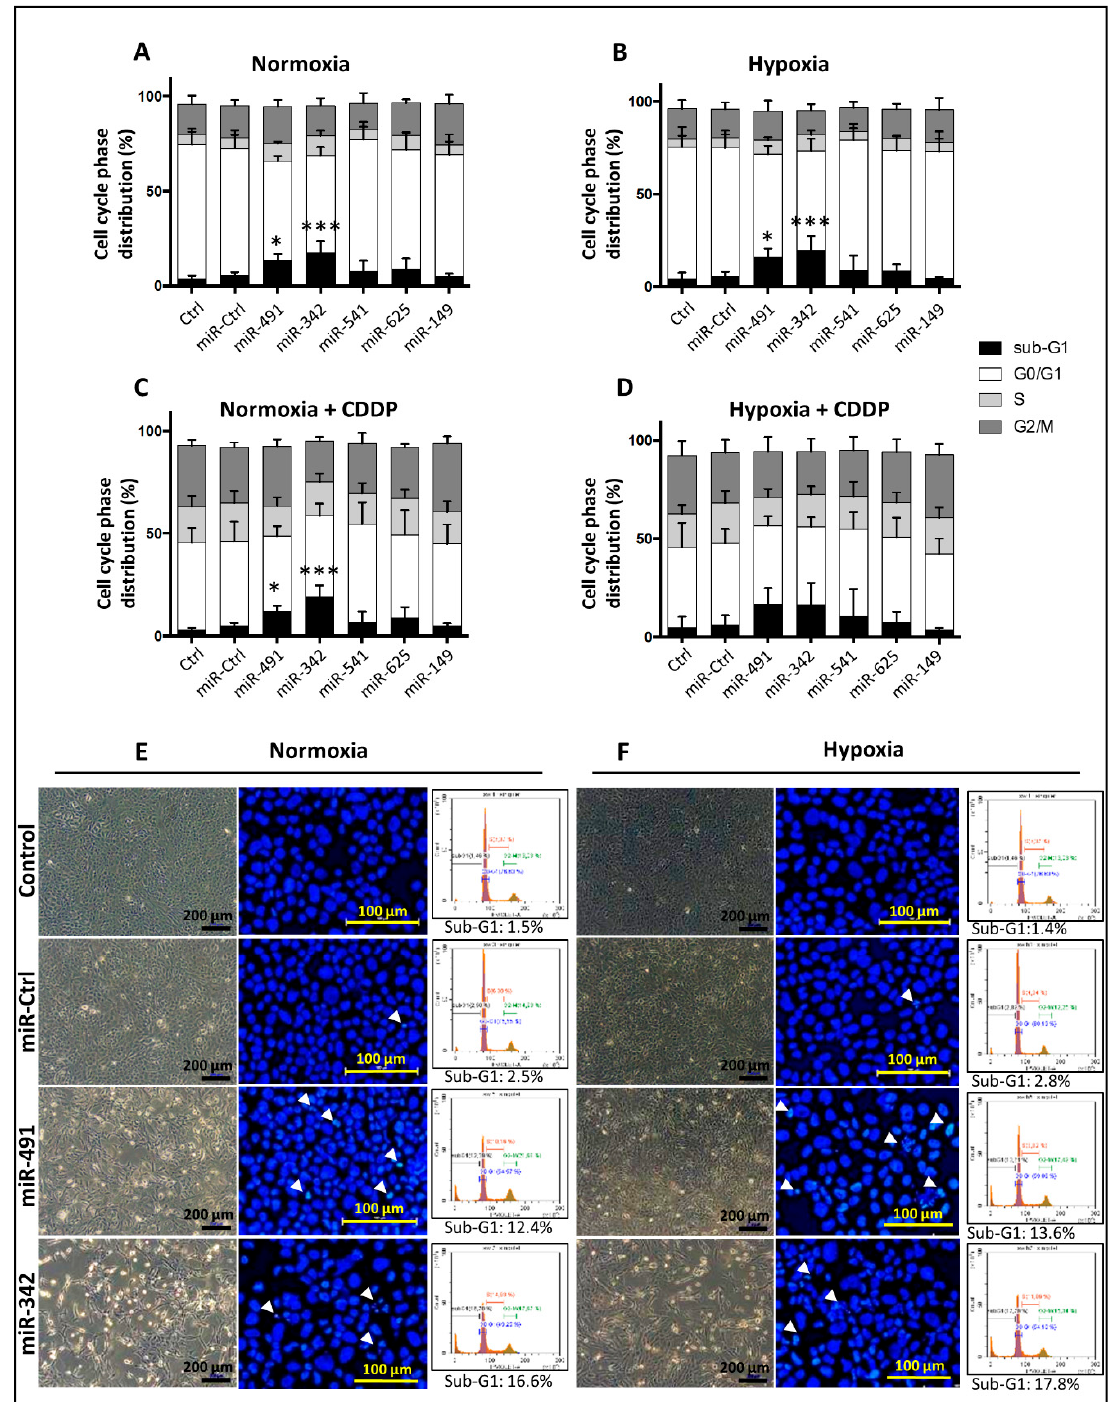
Figure 3 . Functional validation of cytotoxic or chemosensitizing effects of individual miRNAs on SW1353 cells. SW1353 cells were cultured under normoxia ( A , C , E ) or hypoxia ( B , D , F ). They were transfected 24 h after seeding with 20 nM of miR-Ctrl, miR-491-5p, miR-342-5p, miR-541-5p, miR-625-5p or miR-149-5p. An additional treatment with cisplatin (CDDP) (1 µg/mL) was performed 48 h post-transfection (C and D). Analyses were carried out 72 h post-transfection. ( A – D ) Cell cycle phase distribution was analyzed using flow cytometry. The histograms represent the analysis of five independent experiments (mean ± SD) with the different phases of the cycle. Statistically significant differences in the percentage of sub-G1 events between miR-Ctrl and miRNA-treated cells were determined using one-way ANOVA (*: p < 0.05, ***: p < 0.001). ( E , F ) The left panels show the cell morphology obtained under photonic microscopy at the end of the experiment. The middle panels show nuclear morphology obtained after DAPI staining as described in the Materials and Methods section. White arrowheads show cells with condensed and/or fragmented chromatin and cellular debris. The right